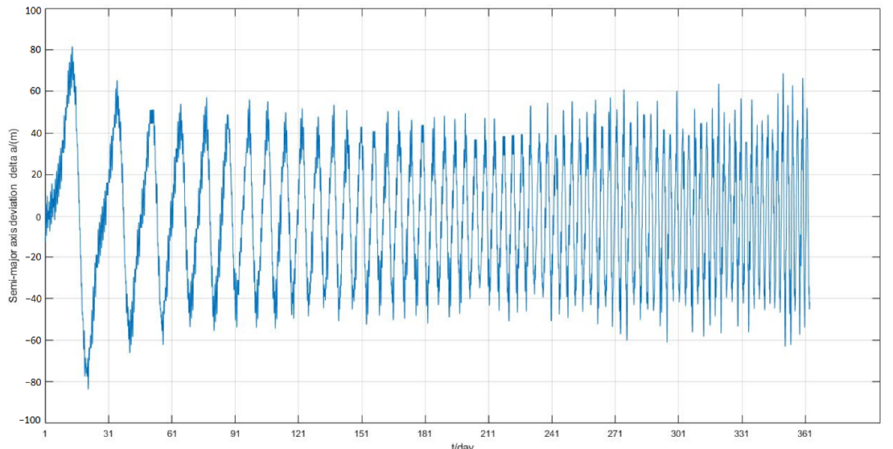
Figure 16. Semi-major axis deviation of two satellites.